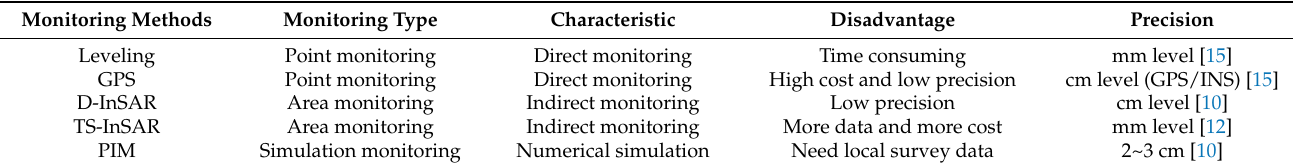
Table 1. Characteristics of various common measurement